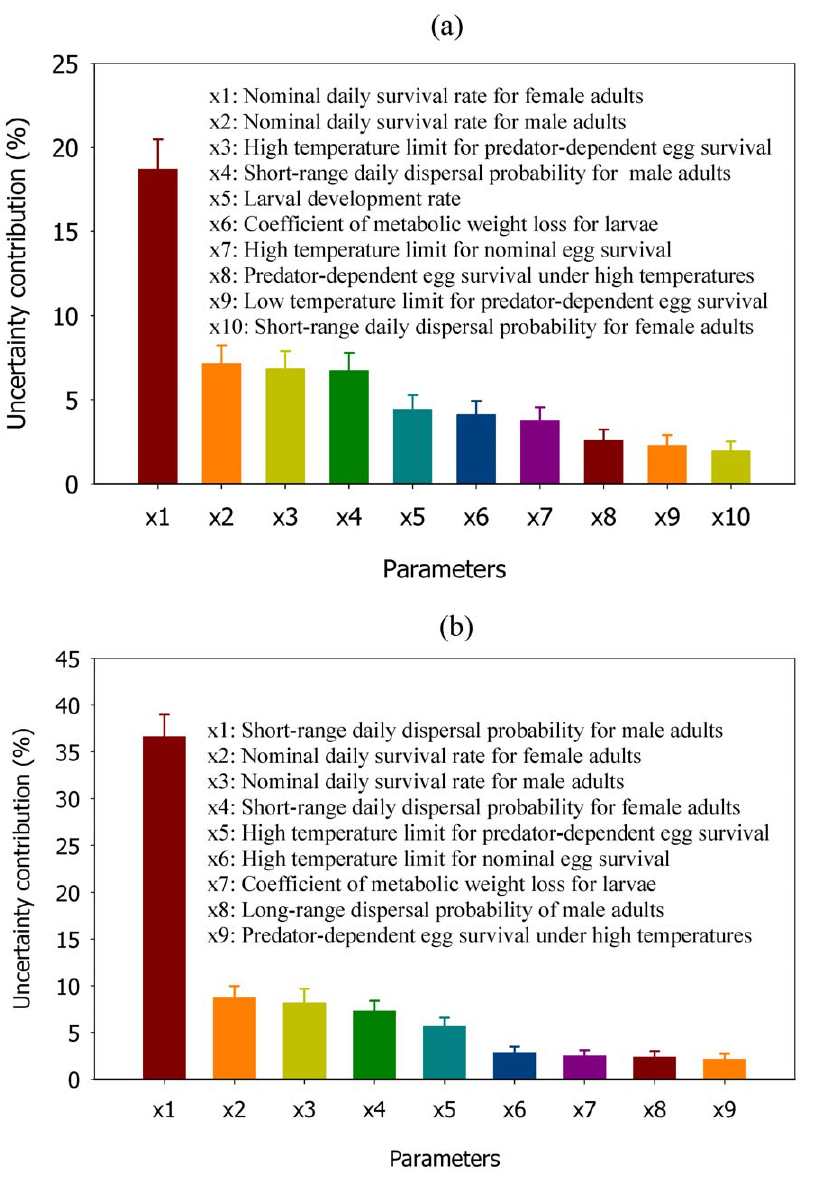
Figure 6. Uncertainty contributions by model parameters for the predicted suppression efficacy. Adults carrying one FK construct are released into the resident population (with natural heterogeneity). a) homogeneous male adult releases; b) point source uniform male adult releases. The suppression efficacy is measured by the percentage reduction in female adult population density, based on the reference density averaged over 3 weeks before the release and the suppressed density averaged over days 200–400 after the release. The vertical bars represent the 95% confidence intervals. To simplify the figures, we only plot those parameters that contribute more than one percent to the uncertainty.